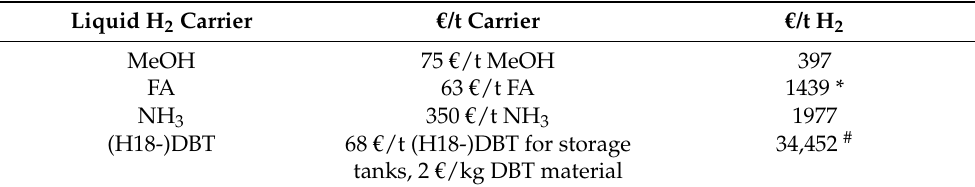
Table 1. Investment cost of storage for different liquid H 2 carriers [91].